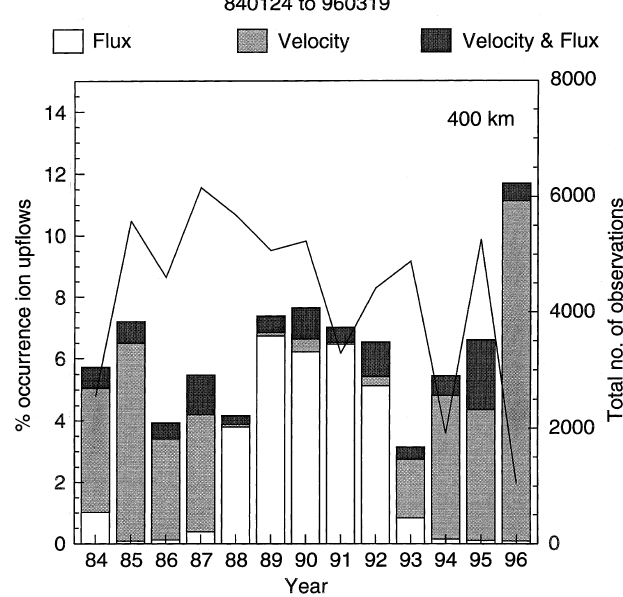
Fig. 5. Frequency occurrence of upflows as a function of year between 1984 and 1986 at 400-km altitude. Histogram bars are subdivided as for Fig. 1